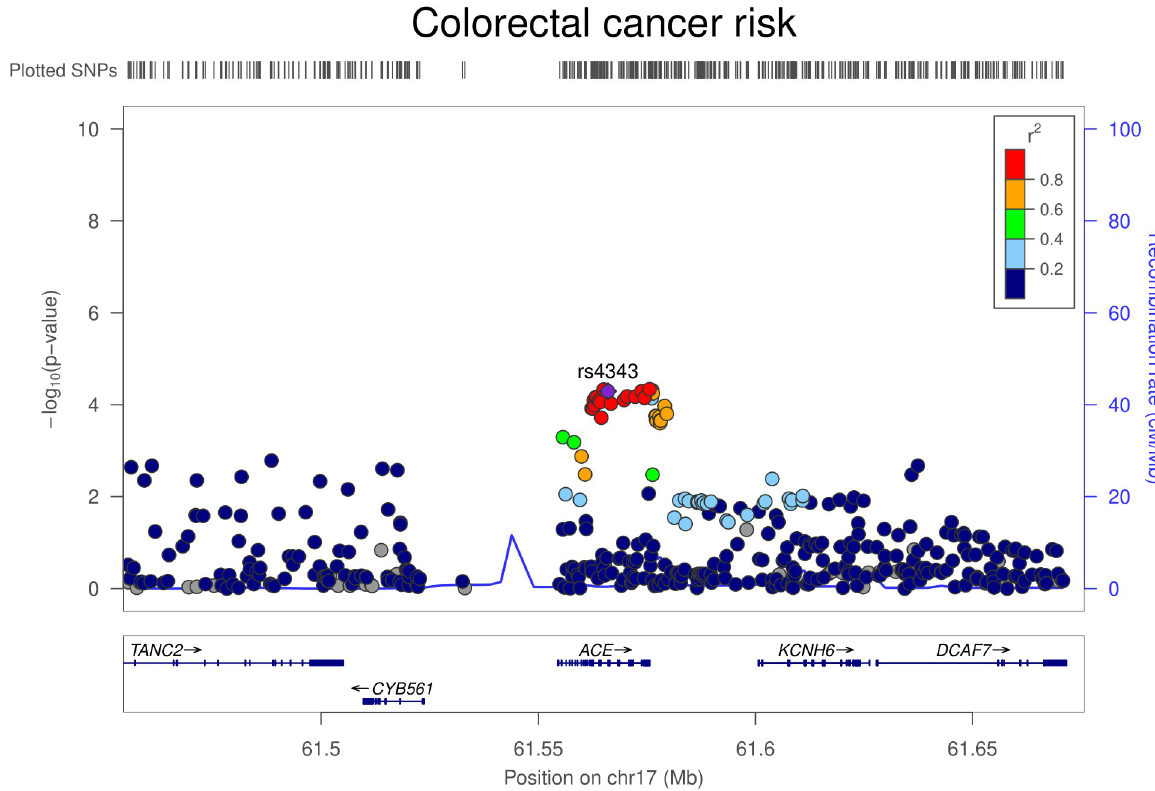
Fig 2. Regional Manhattan plot of associations of SNPs with colorectal cancer risk ± 300kb from the SNP used to proxy serum ACE concentrations (rs4343) in the ACE region. ACE, angiotensin-converting enzyme; Mb, Megabase; SNP, single-nucleotide polymorphism.